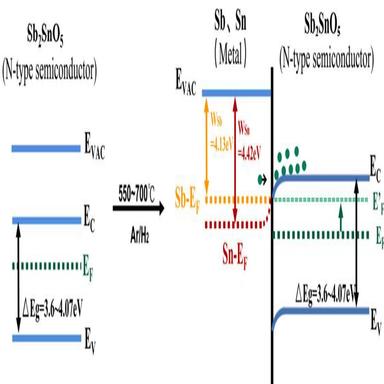
The energy band structure schematic diagram.